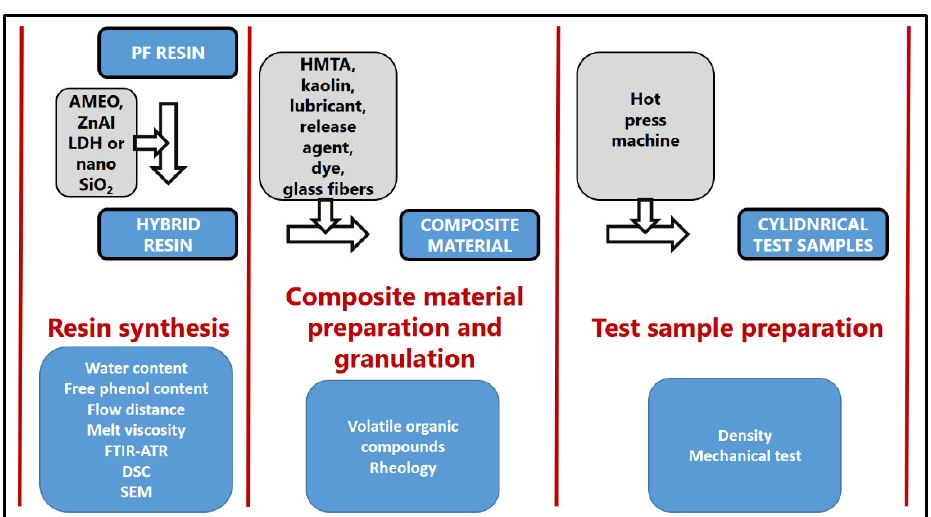
Figure 1. Preparation stages: from resin synthesis to hot-pressed samples.